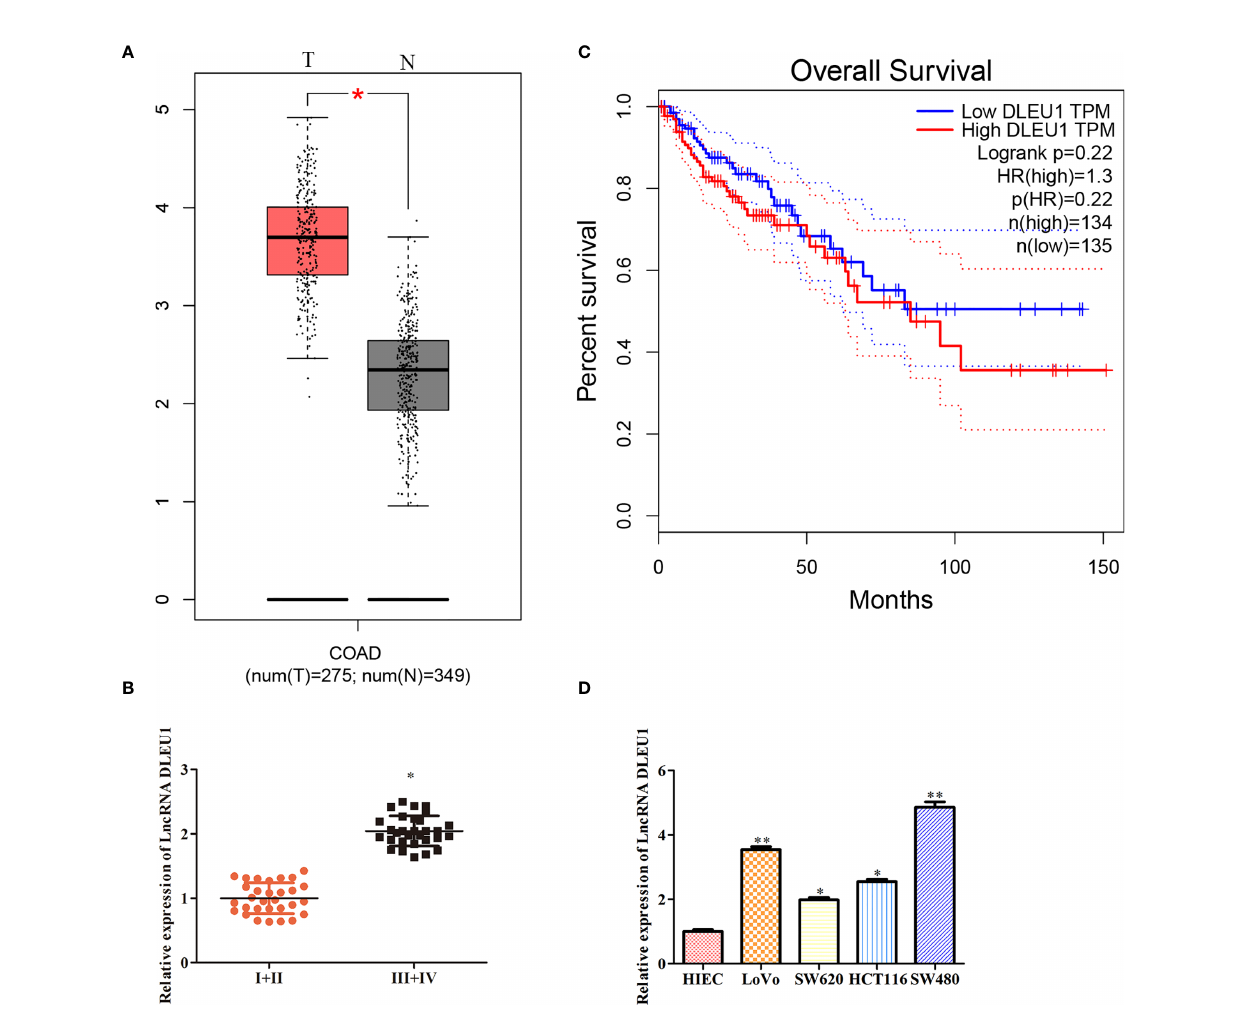
FIGURE 1 | DLEU1 is highly expressed in CRC tissues and cancer cells. (A) The expression pro fi le of DLEU1 was obtained from GEPIA (http://gepia.cancer-pku.cn/ index.html), * P < 0.05 vs . non-tumor tissues. (B) The relative expression of DLEU1 was determined by qRT-PCR in CRC tissues of different clinical stage, * P < 0.05 vs . stage I + II tissues. (C) Overall survival curves showed the association between the DLEU1 level and overall survival of CRC patients were obtained from GEPIA (http://gepia.cancer-pku.cn/index.html). (D) The relative expression of DLEU1 was determined by qRT-PCR in CRC cell lines, * P < 0.05, ** P < 0.01 vs . normal intestinal epithelial cells